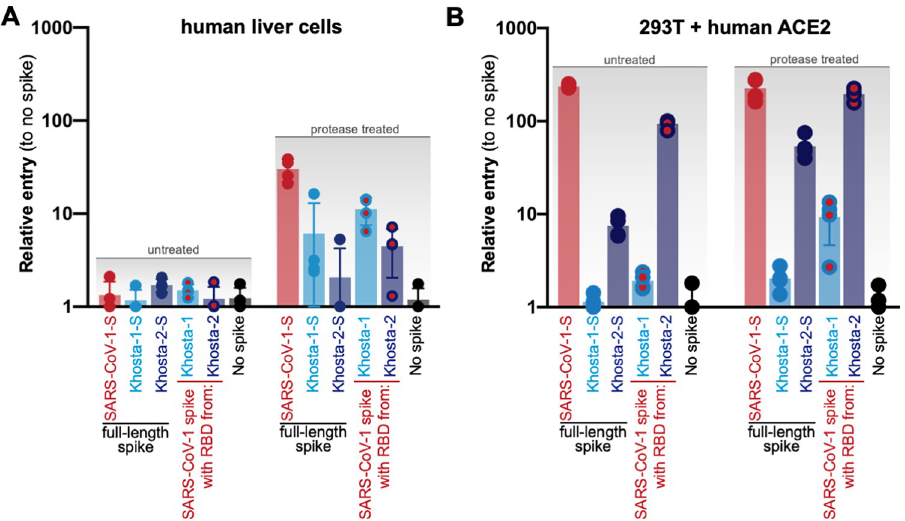
Fig 3. Full-length Khosta spikes infect human cells. ( A ) Huh-7 or ( B ) 293T cells that stably express human ACE2 cells were infected with VSV pseudotypes bearing the indicated spike